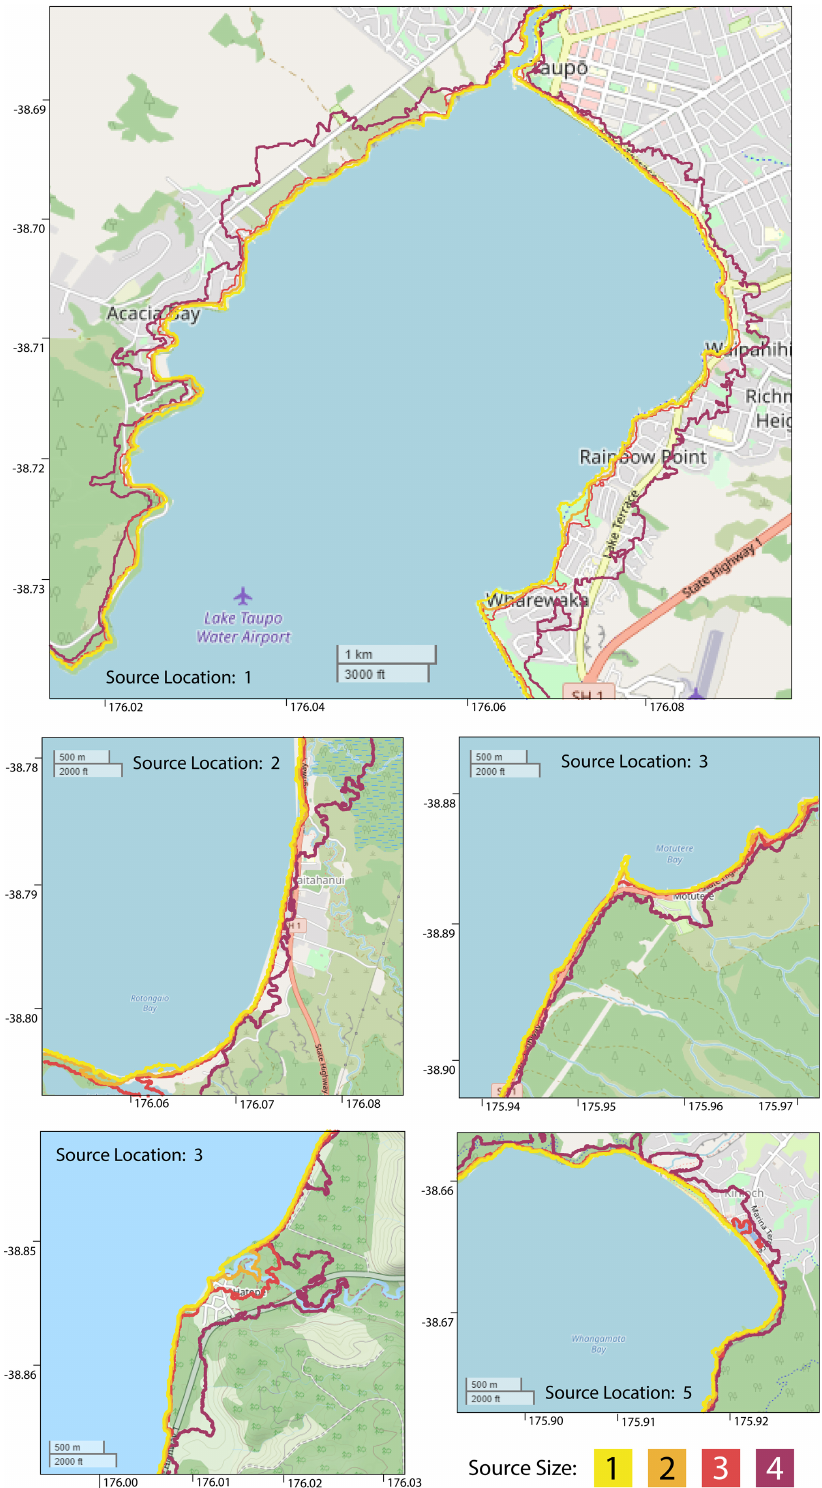
Figure 8. Inundation contours by size for the five boxed areas shown in Fig. 2, where only the closest source for each location is shown. Map imagery © OpenStreetMap contributors 2022. Distributed under the Open Data Commons Open Database License (ODbL) v1.0.